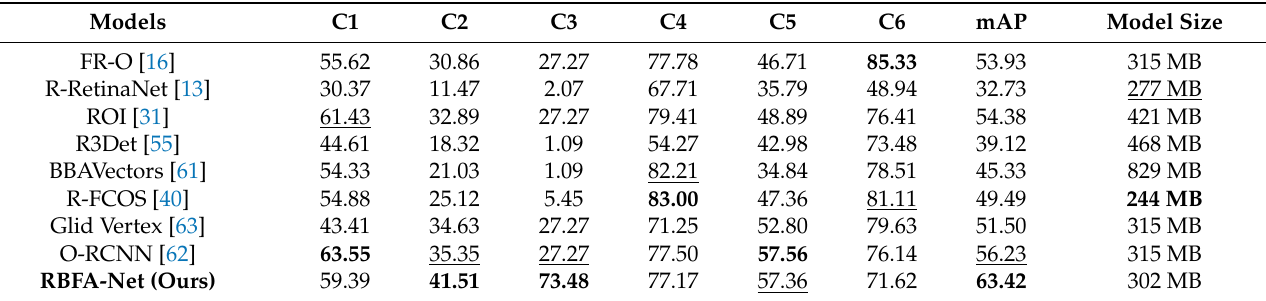
Table 3. Quantitative evaluation comparison with the eight state-of-the-art detectors. Labels C1–C6 correspond to ore–oil ships, fishing boats, law enforcement ships, dredger ships, bulk cargo ships and container ships.